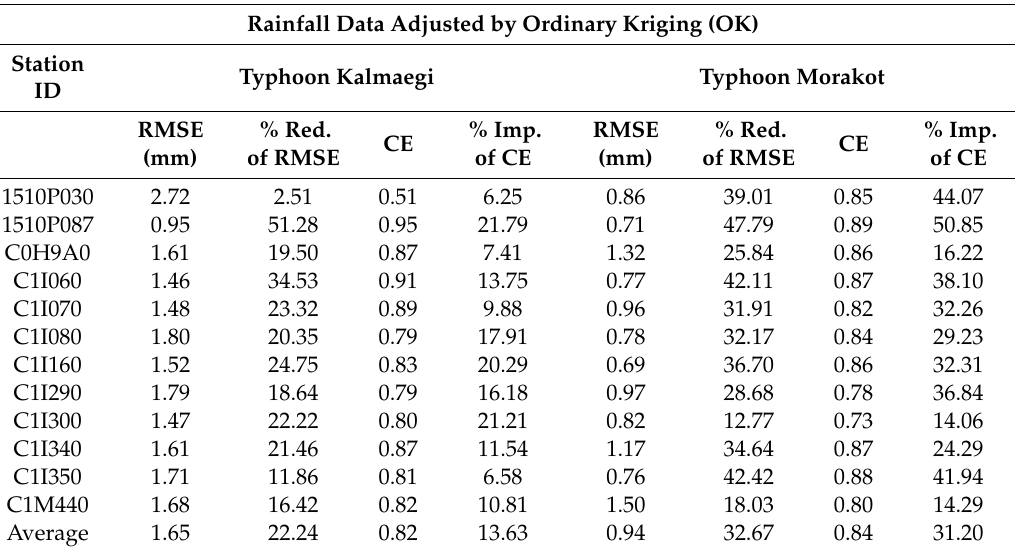
Table 3. RMSE and CE for the adjusted radar rainfall values using ordinary kriging (OK) for stations inside the watershed boundary during the events of typhoons Kalmaegi and Morakot. The values of percentage reduction (% Red.) in the RMSE and percentage improvement (% Imp.) in CE are also included.